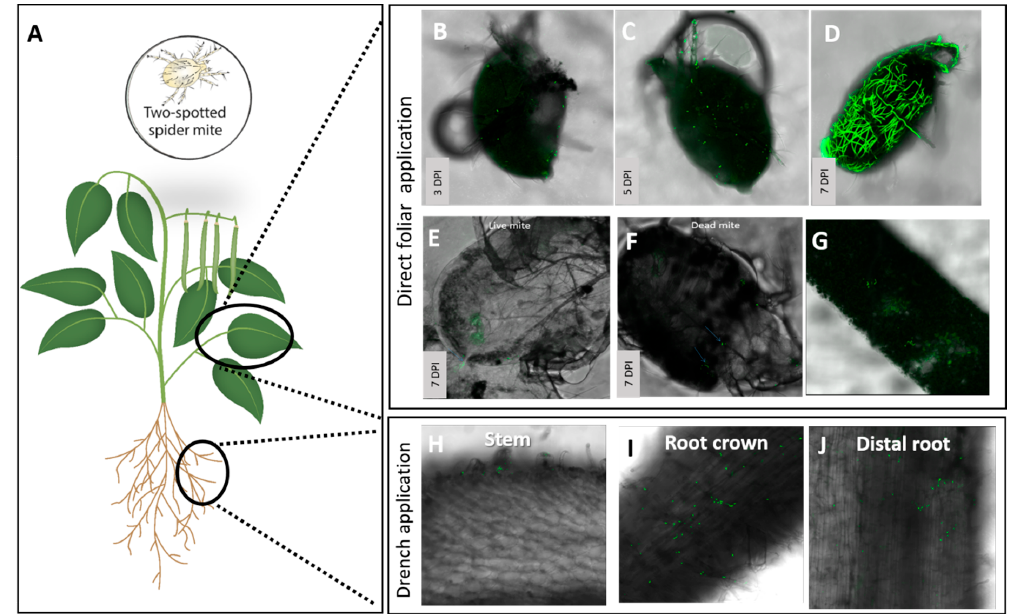
Figure 2. Observation of Tetranychus urticae mite infestation and endophytic establishment of Mb7 in bean plants following spray and drench application with conidia suspension (10 7 conidia mL − 1 ). ( A ) Sites of spray, drench and examination of bean plants. ( B – D ) Progression of Mb7 infection in adult T. urticae mites after direct application on plant. ( E , F ) Adult mites’ acquisition of Mb7 conidia from the leaf surface seven days after a spray application. ( G ) Mb7 conidia on a bean leaf cross section. ( H – J ) Mb7 conidia and germlings on bean roots after a drench application. DPI, days post inoculation.